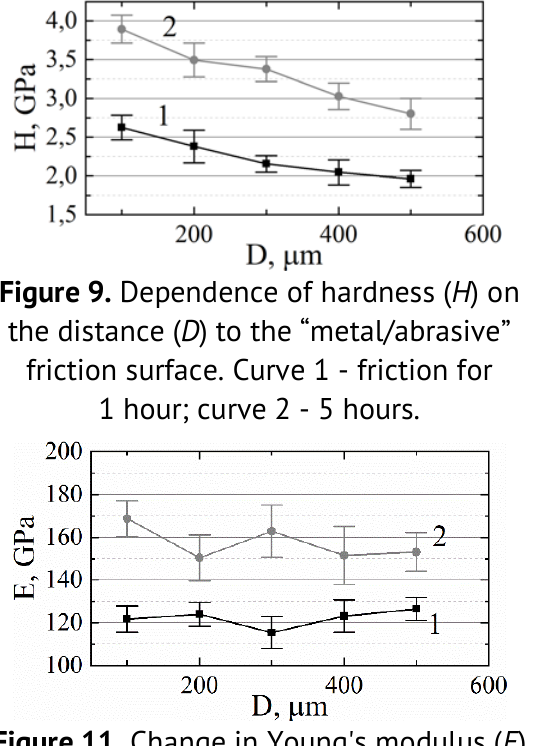
Figure 11. Change in Young's modulus ( E ) with distance ( D ) increasing to the “metal/abrasive” friction surface. Curve 1 - friction for 1 hour; curve 2 - 5 hours.